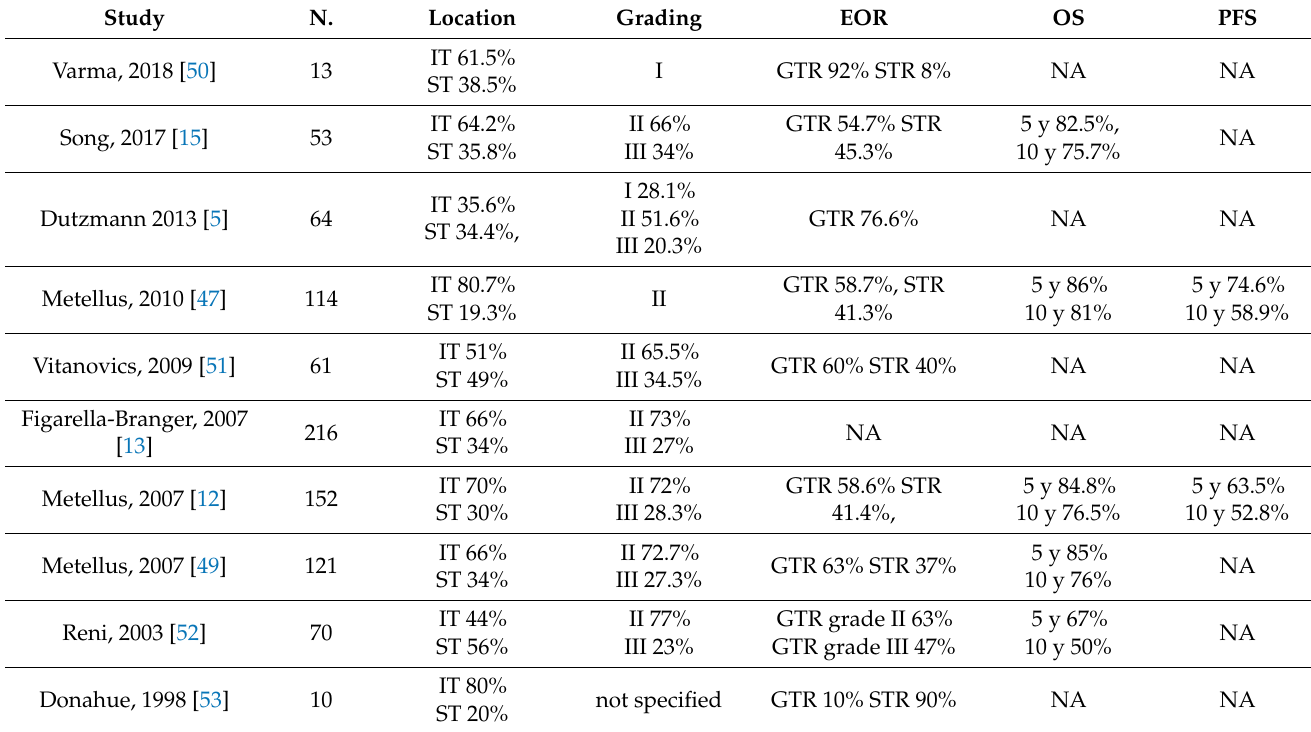
Table 2. Important studies evaluating the role of surgery in ependymoma patients. IT: infratentorial; ST: supratentorial. GTR: gross total resection; STR: subtotal resection; y = years; NA = not